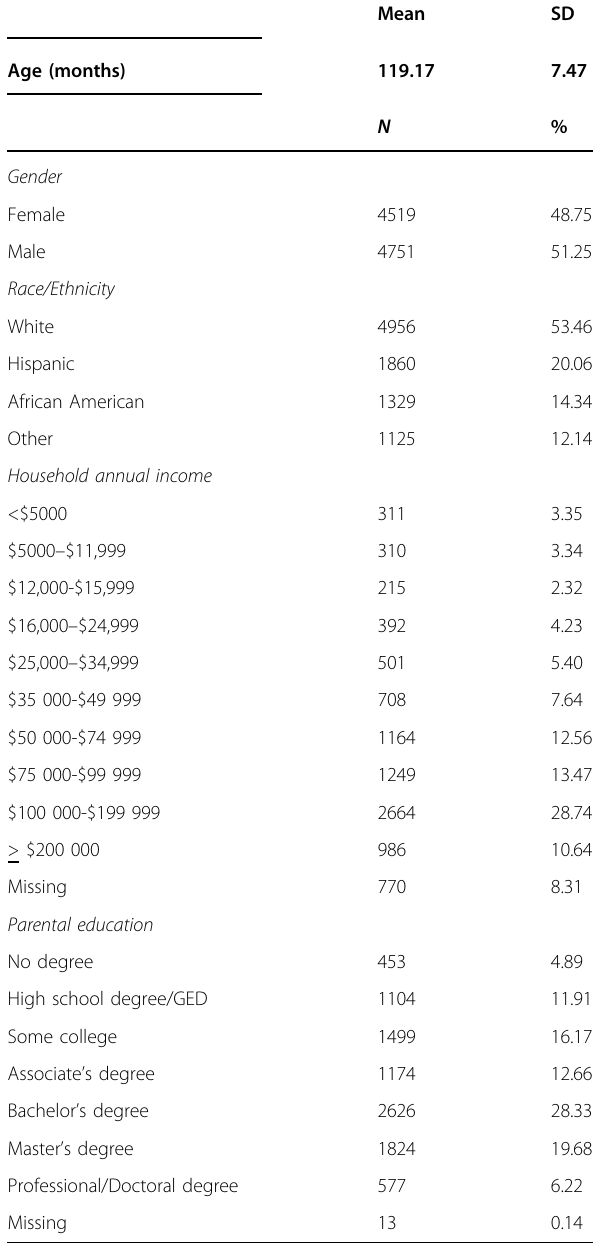
Table 1 Demographics of the sample ( N =